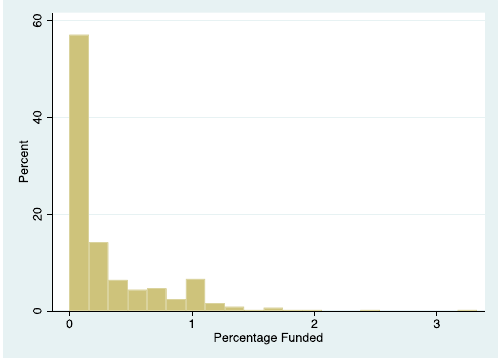
Figure 2. Histogram of funding density.